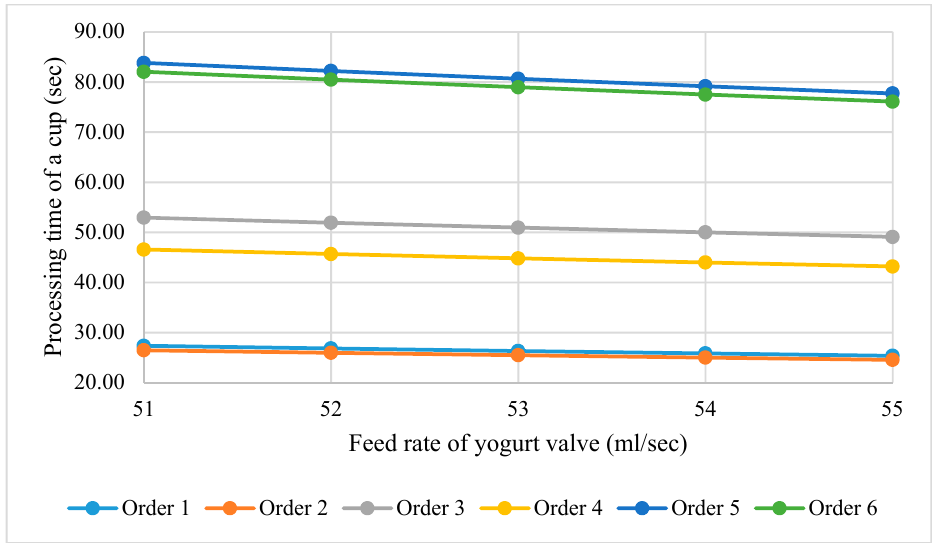
Figure 7. The effect of feed rate of yogurt valve on the processing time of a cup.